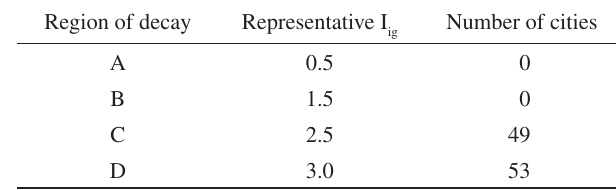
Table 4. Representative climatic Index for four classes of